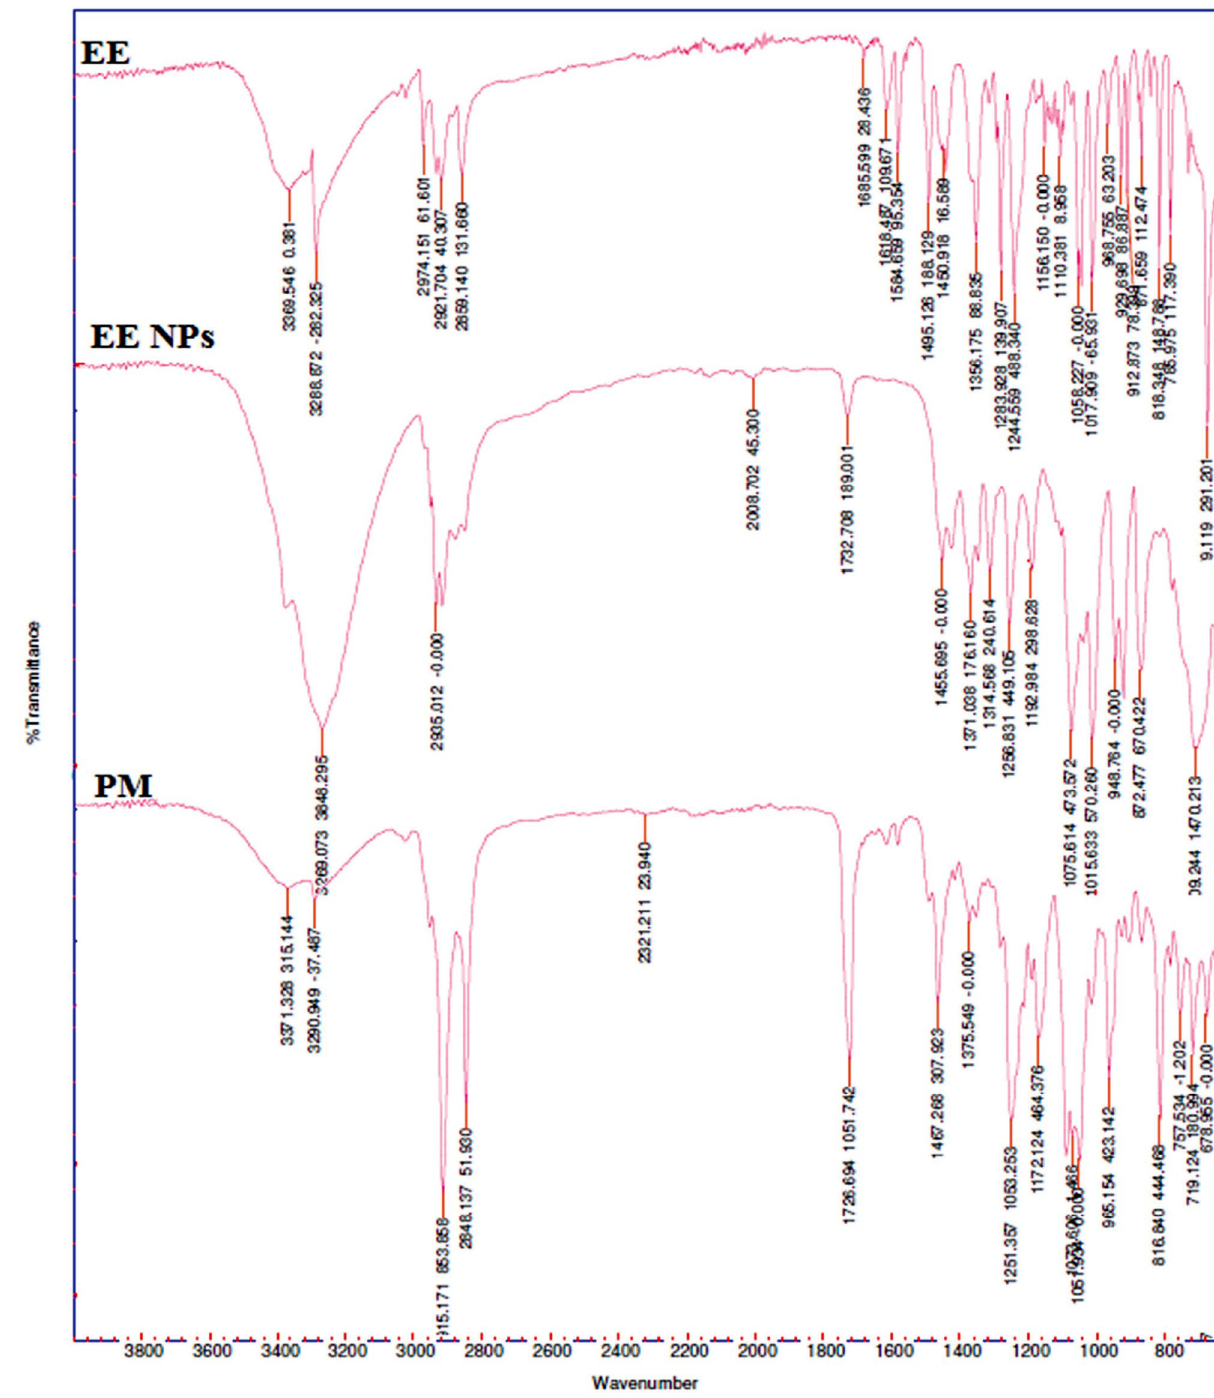
Figure 9. FTIR spectrum of: a) pure ethinyl estradiol, b) optimized nanosuspension (EENPS), c) physical